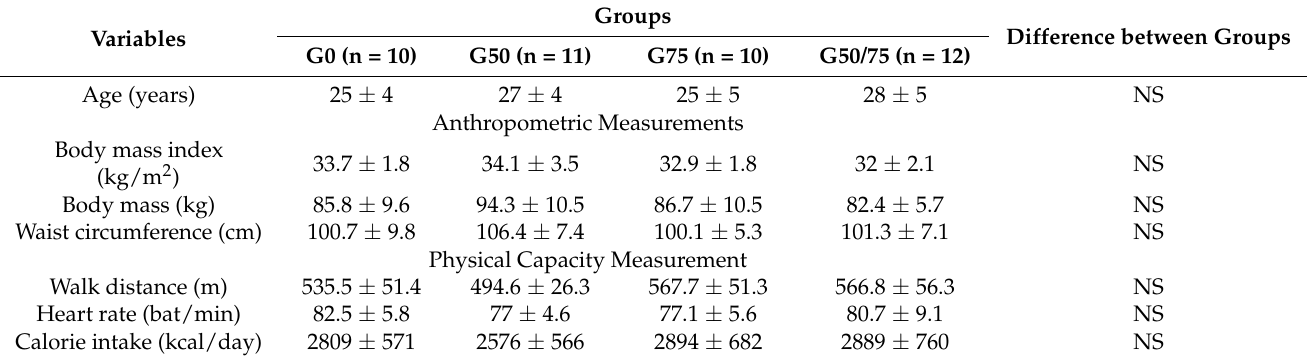
Table 1. Baseline characteristics of the study